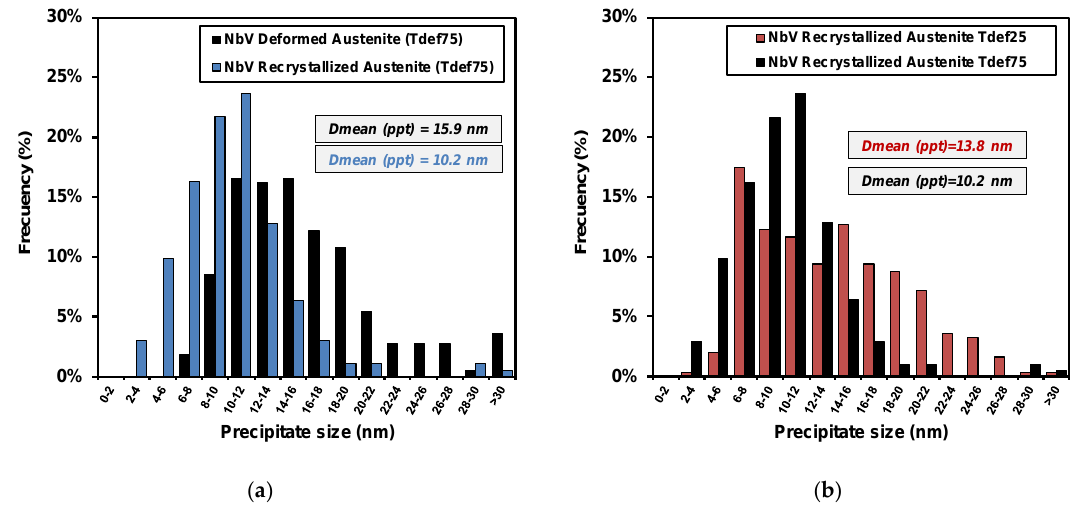
Figure 12. Precipitate size distribution measured for ( a ) NbV recrystallized austenite and NbV deformed austenite for Tdef75. ( b ) Tdef25 and Tdef75 for NbV recrystallized austenite.